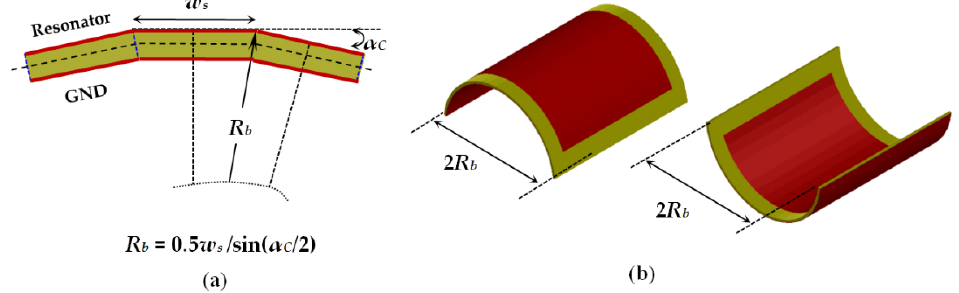
Figure 12. ( a ) Definition of the relation between the curvature angle α C and bending radius R b ; dashed line: middle line in the resonator substrate, where the effective electrical length of the reso- nator is formed; ( b ) resonance structures on positive (+ α C ) and negative (– α C ) bent substrate (the bending radius R b is always determined to the side of the resonator layout).